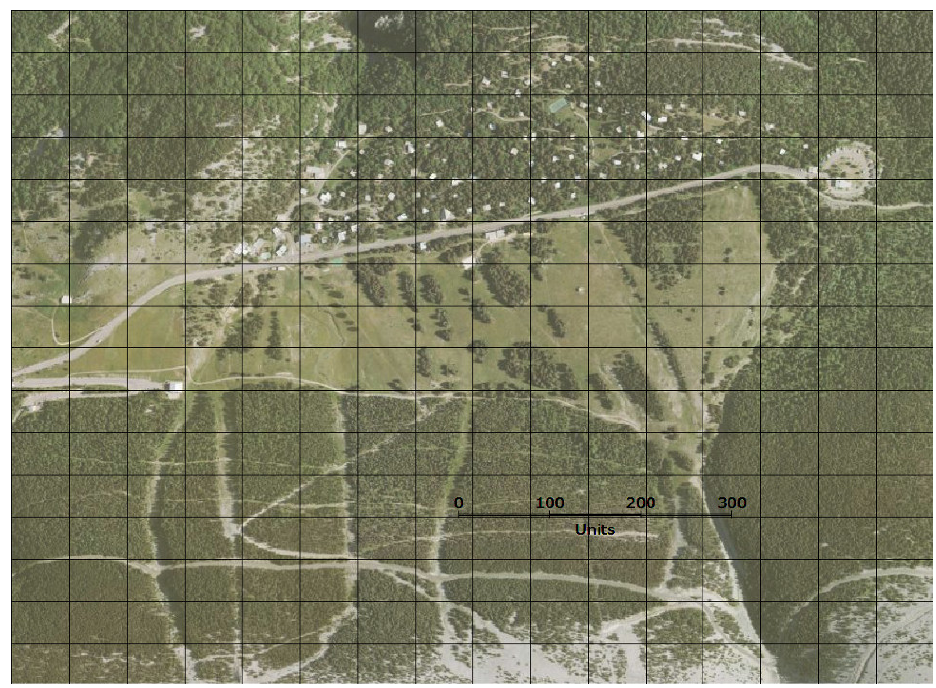
Figure 3. Partition by a grid 16 × 16 with rectangular polygons (GRID-16).